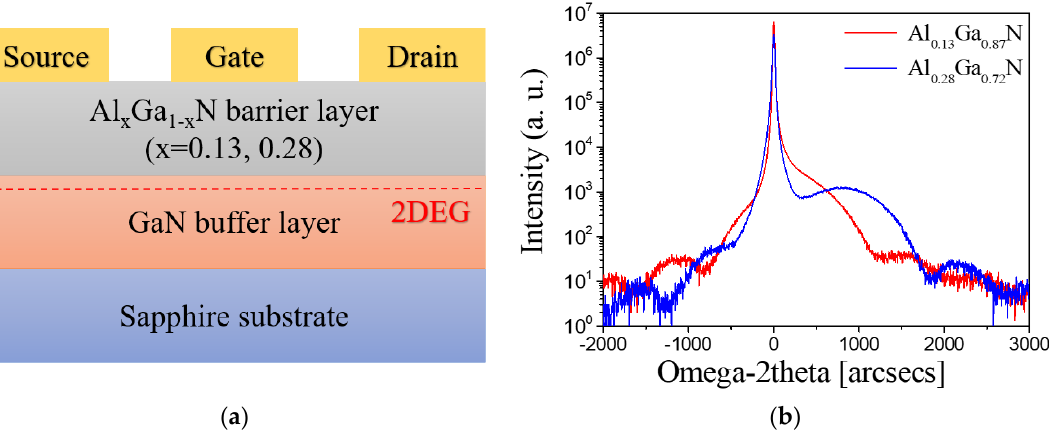
Figure 1. ( a ) Schematic cross-sectional view of the fabricated AlGaN/GaN HEMTs; ( b ) High resolution X-ray diffraction (HRXRD) of symmetric (0002) ω-2θ scan of AlGaN/GaN heterostructures for different Al compositions.